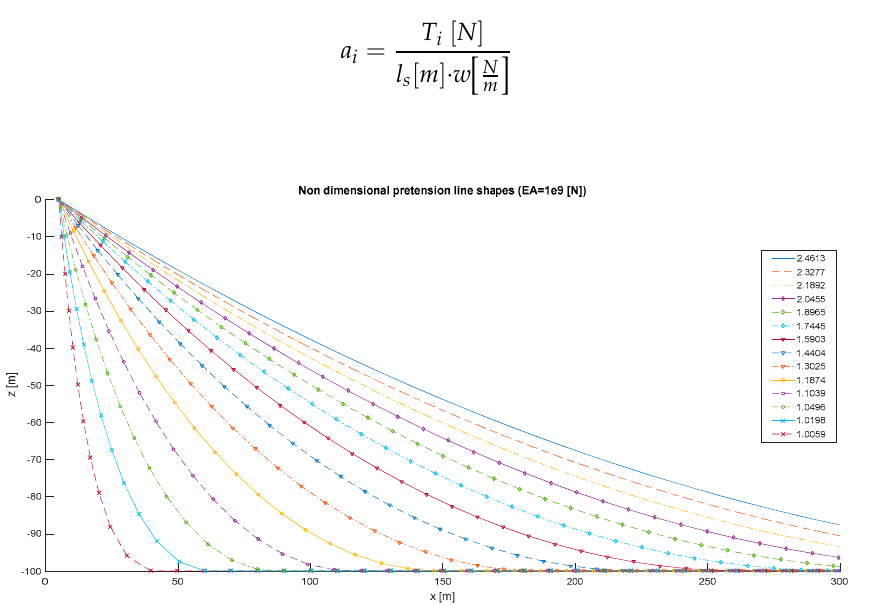
Figure 1. Non-dimensional pretension line shapes for axial stiffness EA=1e9[N].